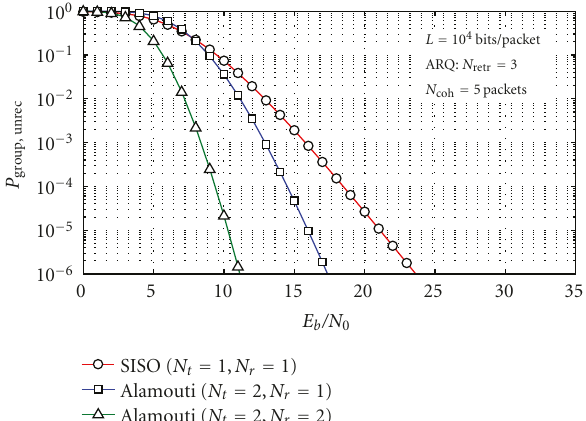
Figure 11: Probability P group, eras that at least one packet from a packet group is definitively erased (ARQ with maximum 3 retransmissions).